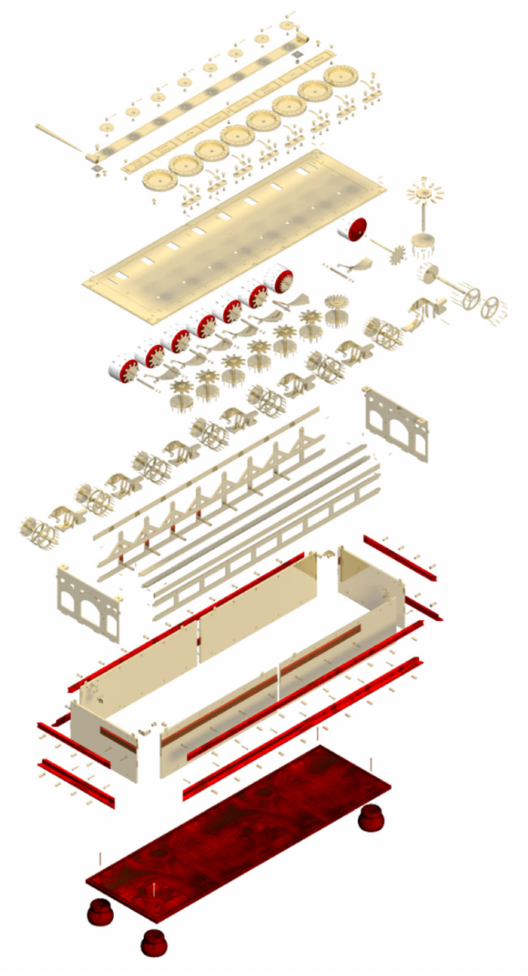
Figure 22. Exploded view of the 3D CAD model of the